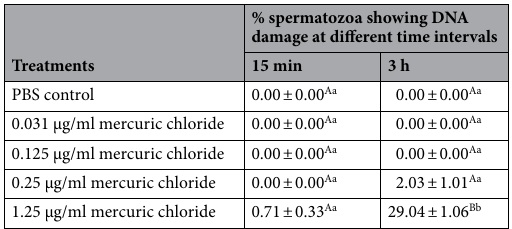
Table 4. Effect of in-vitro exposure of buck spermatozoa to different concentrations of mercuric chloride (0.031–1.25 µg/ml) on DNA damage in sperm cells at different time intervals. Data presented are mean ± SE of the semen samples of six bucks. Different capital superscripts in the rows indicate significant (p < 0.05) differences between the different time intervals. Different small superscripts in the columns indicate significant (p < 0.05) differences between control and different treatment groups.